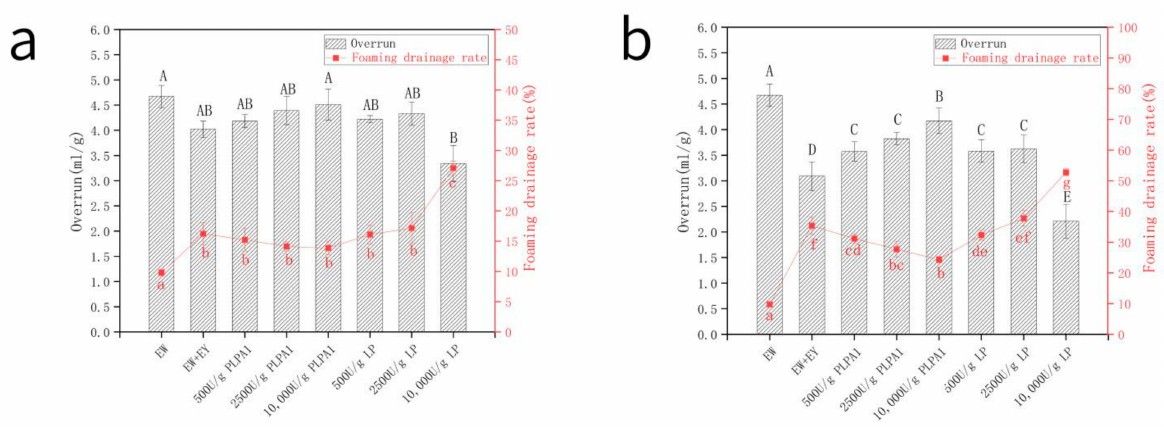
Figure 3. Overrun and foaming drainage rate of samples. Samples mixed with 0.5 wt% EY ( a ) and samples mixed with 1 wt% EY ( b ) hydrolyzed by various concentrations (500 U/g, 2500 U/g, 10,000 U/g) of LP, and PLPA1. (Samples correspond to Table 2). Different letters for the same parameter indicate significant differences ( p < 0.05) between treatments in the two figures